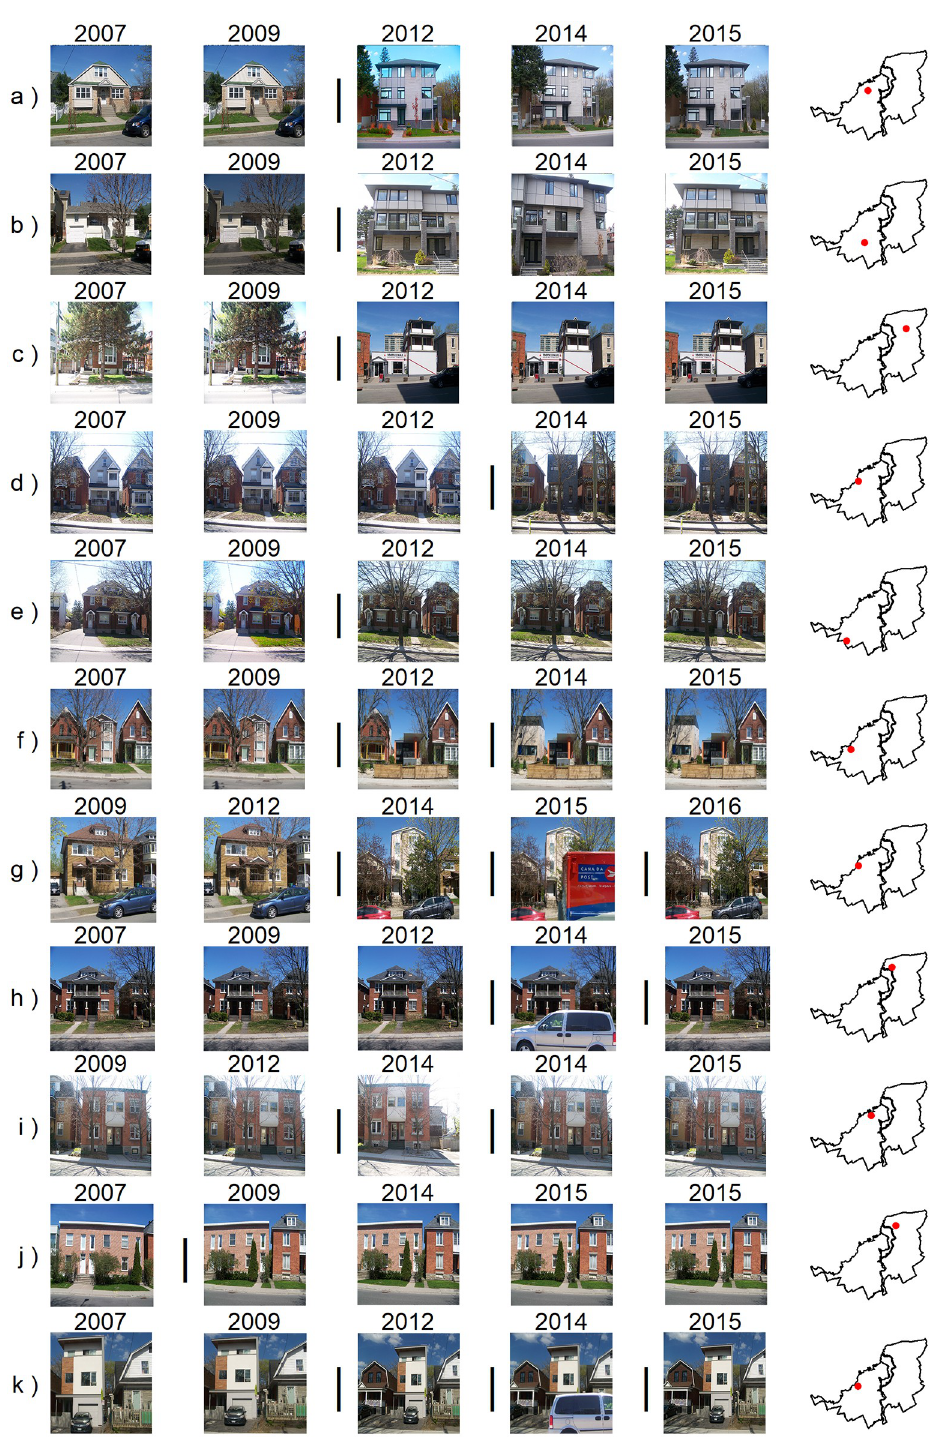
Fig 7. Examples of SCNN-FC-8 detections. The photos here are the authors’ and have been manipulated for illustrative purposes. In order to comply with CC-BY copyright, a figure containing detected changes within GSV image sequences can be found in this research project’s GitHub repository at: https://github.com/laggiss/ DeepMapping/blob/master/GSVFIGS/fig7_online.png. The reader should refer to the external figure because it fully captures the descriptions in the text. Each row represents the time series of GSV images for the unique location specified in the map plot at the end of each row. The vertical bar ( ׀ ) symbol between any two successive years indicates